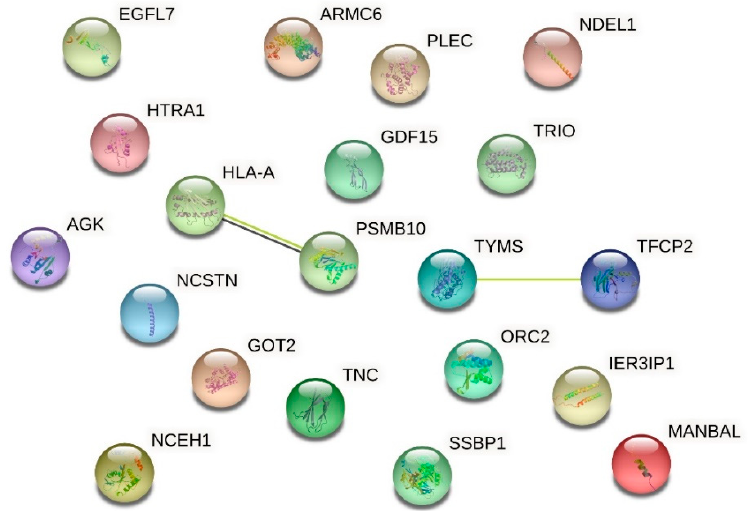
Figure 9. Network of down-regulated proteins in HMEC-1 exposed to urea. The network, obtained with the software STRING, includes proteins that were found to be down-regulated in cells treated with 5 g/L urea compared to cells treated with 0.25 g/L urea, for 72 h.